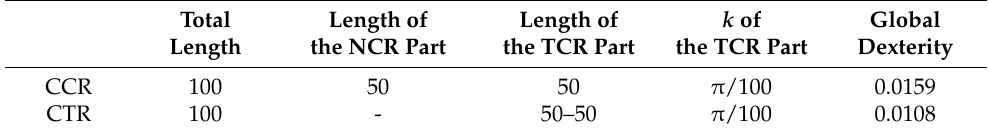
Table 4. The dexterity index of the CCR and TCM.